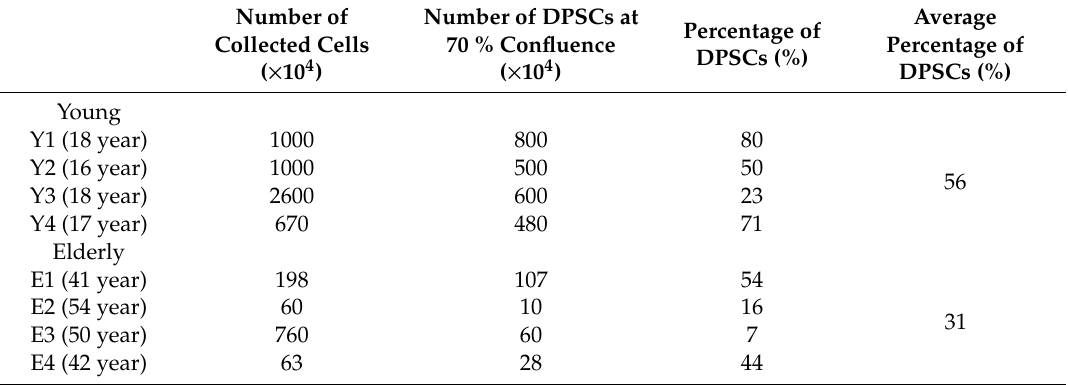
Table 1. Initial percentage of dental pulp stem cells (DPSCs) derived from young and elderly patients.